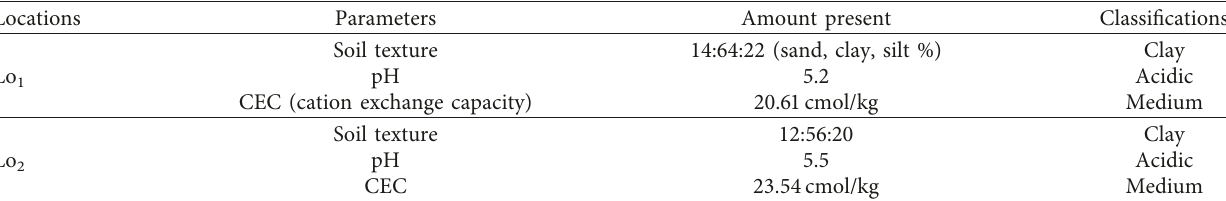
Table 2: Soil characteristics of experimental